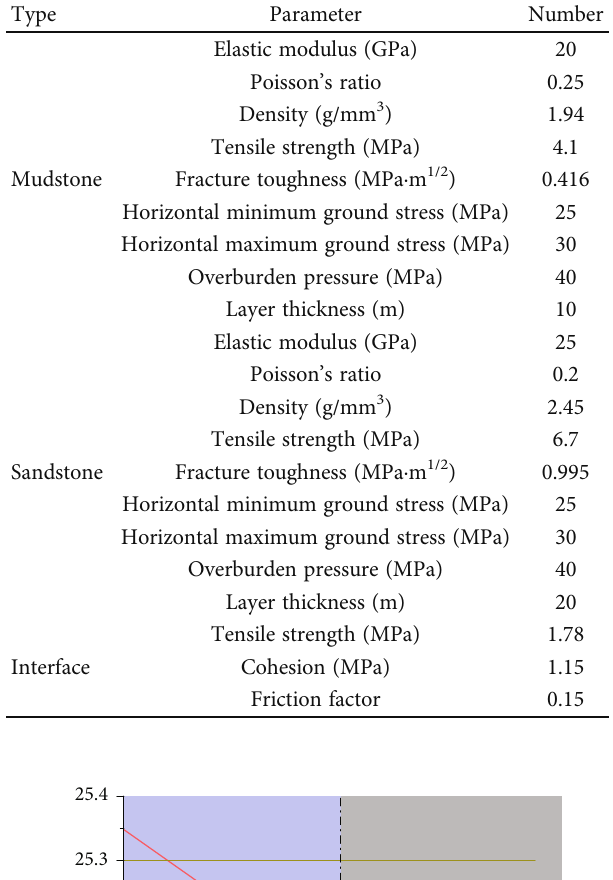
Table 4: Basic parameters.